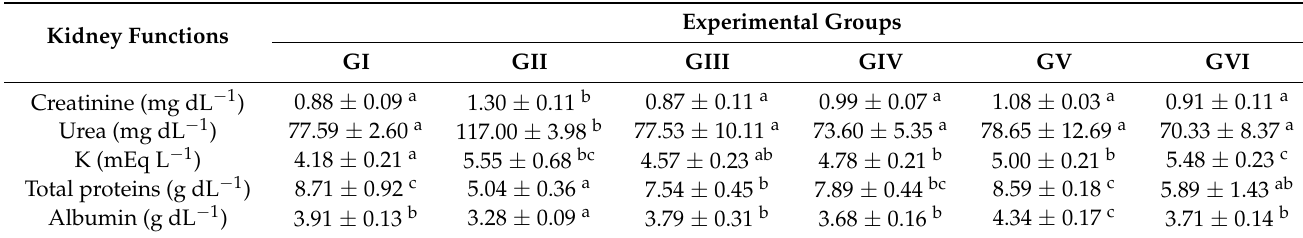
Table 3. Effect of oral administration of A. hierochuntica extracts on biochemical kidney markers in CCl 4 -induced toxicity in rats (mean ± SE), n = 6.